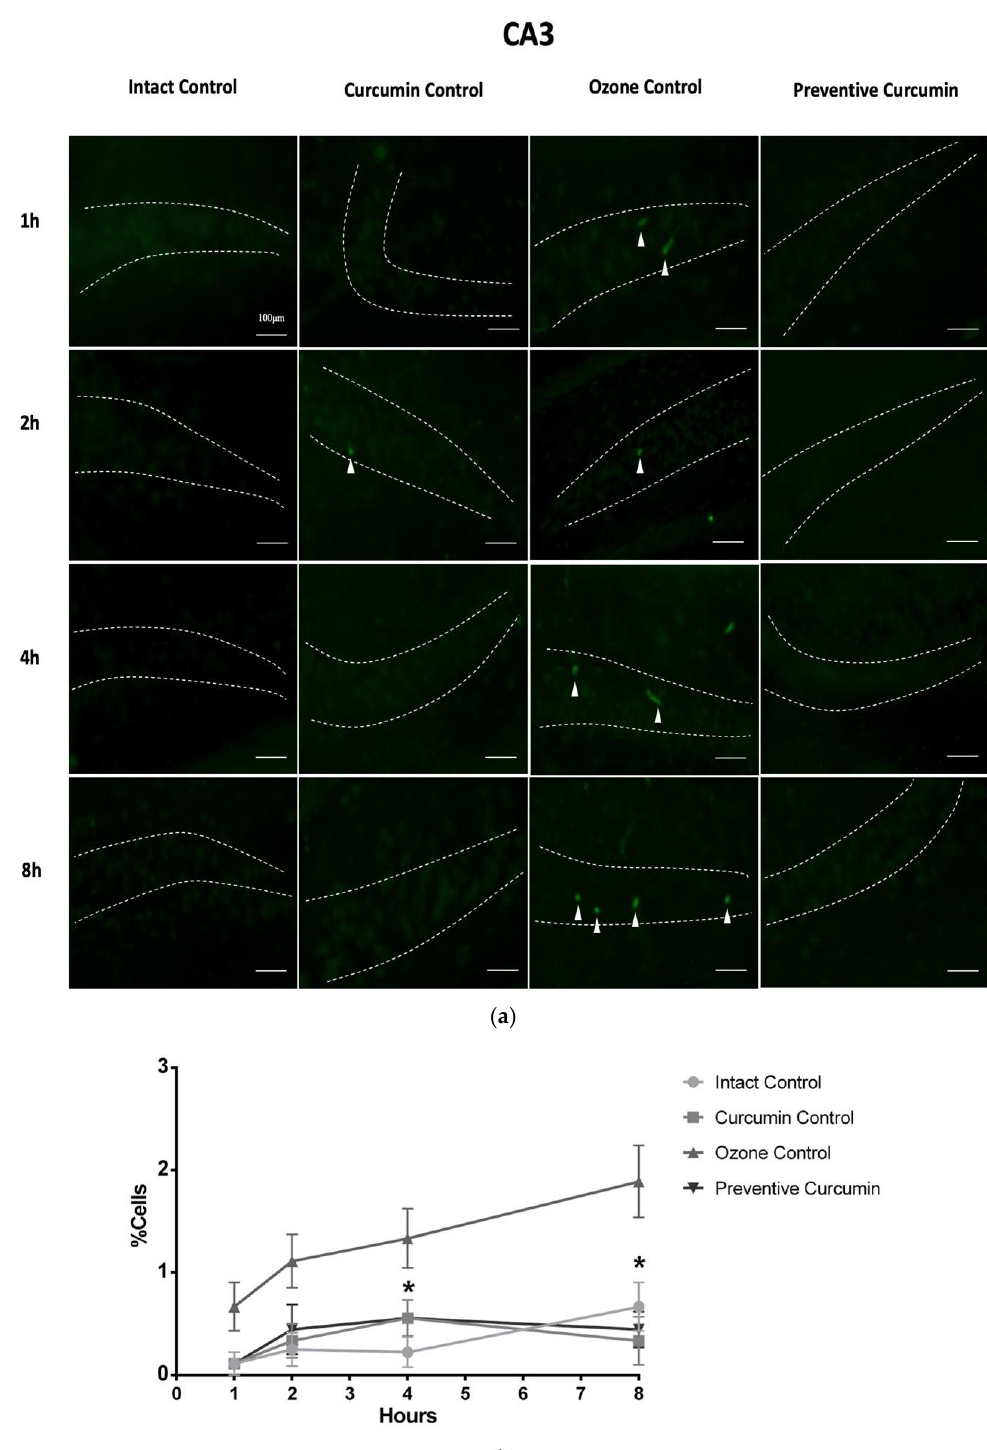
Figure 4. Effect of CUR on hippocampal neurodegeneration after short-term O 3 exposure (Table S4). CA3 region was evaluated by the Fluoro-jade C stain. ( a ) The panel shows representative images of brain sections at different exposure times for each experimental group ( n = 5) where positive cells (Green fluorescence) are indicated with white arrowheads, dashed lines indicate the CA3 area. ( b ) The graph illustrates the comparison of the degenerative cell percentage at each exposure time in the experimental groups; results are expressed as mean values ± SEM, the asterisk indicates a statistical difference between the preventive curcumin and ozone control groups ( p < 0.05) at 4 and 8